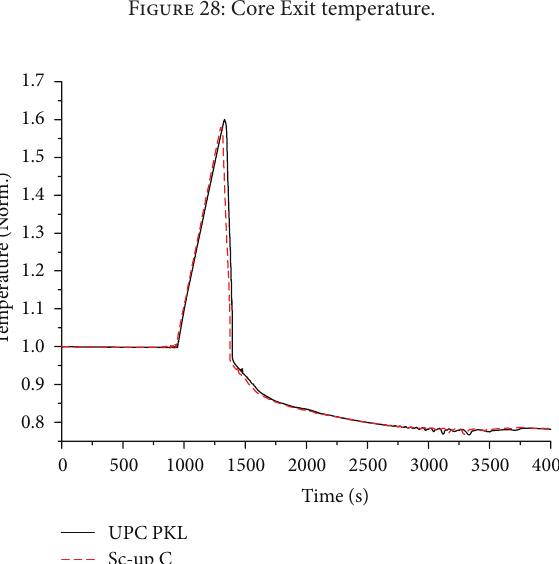
Figure 28: Core Exit temperature.